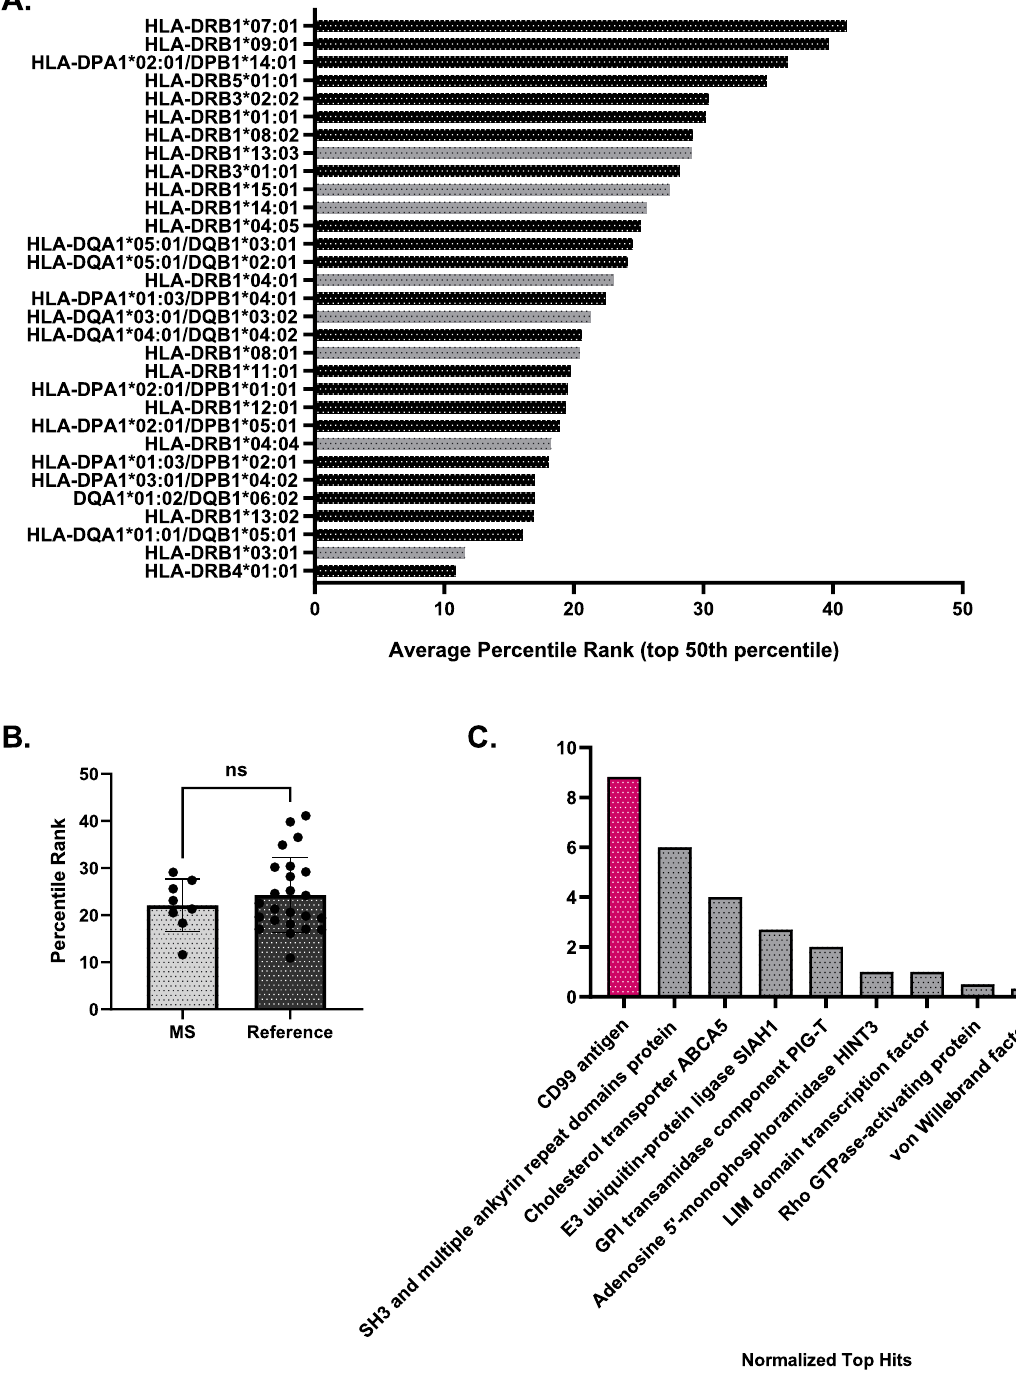
Figure 3. MHC-binding prediction provides insight on proteins which may engage in molecular mimicry beyond PLP. ( A ) MHC-binding prediction tool by the IEDB was used to determine the binding of nucleocapsid peptide hits from the PEPMatch analysis and MS-associated alleles (gray) versus a reference set of alleles (black) 25 . Shown are the top 50th percentile of average binding predictions of all 15mer nucleocapsid peptides from the original analysis and their respective HLA alleles that are predicted to bind. The lower the percentile rank, the stronger the predicted binding between the allele and the set of peptides run in the analysis. ( B ) Data from ( A ) grouped by allele classification. ( C ) Peptide:allele combinations with a percentile rank of 10th or less were collected and assessed for their respective MS-associated protein matches from the original PEPMatch analysis; plotted are the proteins that were returned from this analysis that are normalized to their respective number of peptides